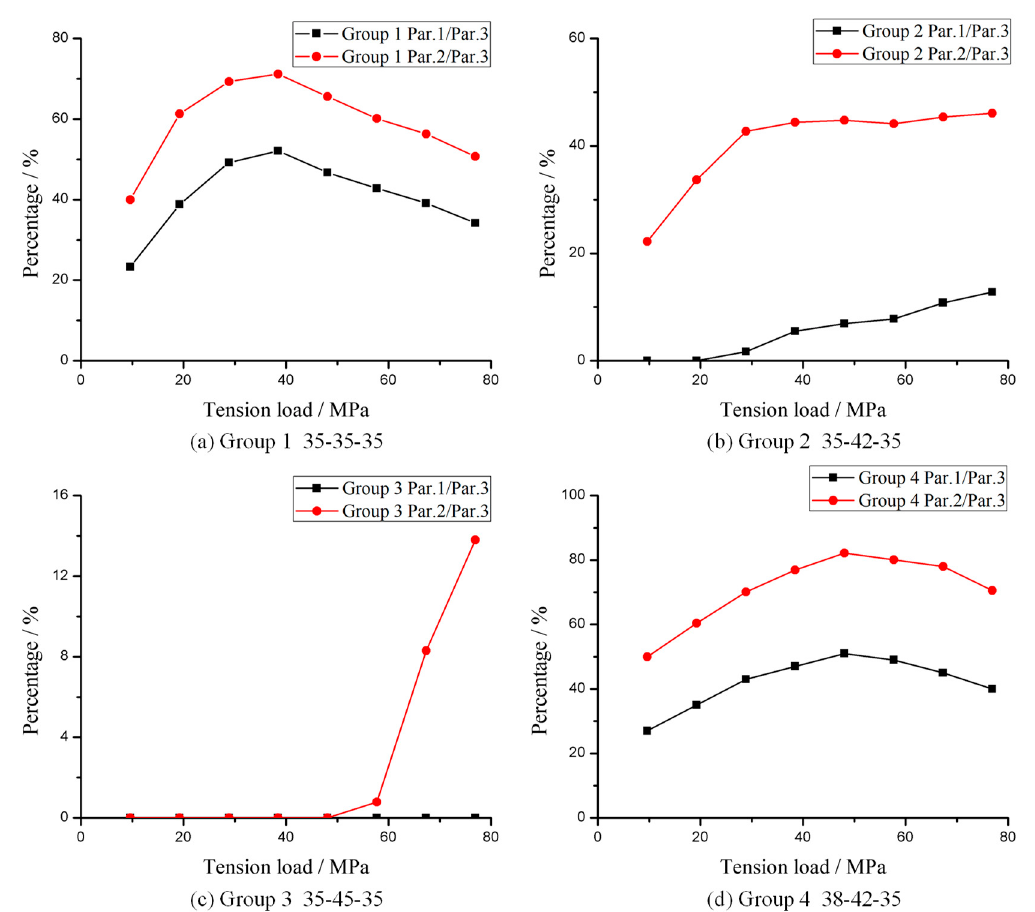
Figure 11. Curves of part strain ratio. ( a ) Group 1 35-35-35. ( b ) Group 2 35-42-35. ( c ) Group 3 35-45-35. ( d ) Group 4 38-42- 35.